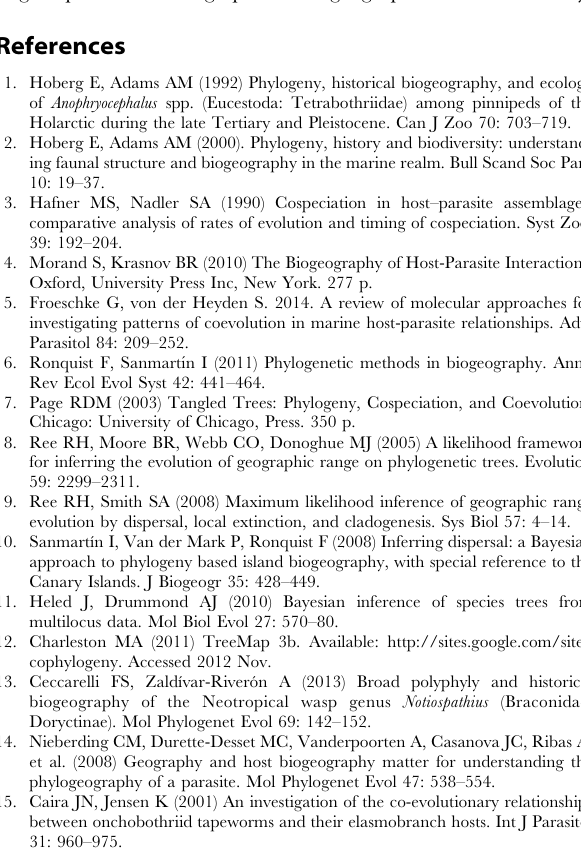
Figure S1 Hydrological systems of this study. Table S1 Additional records of Margotrema in fresh- water fish species from